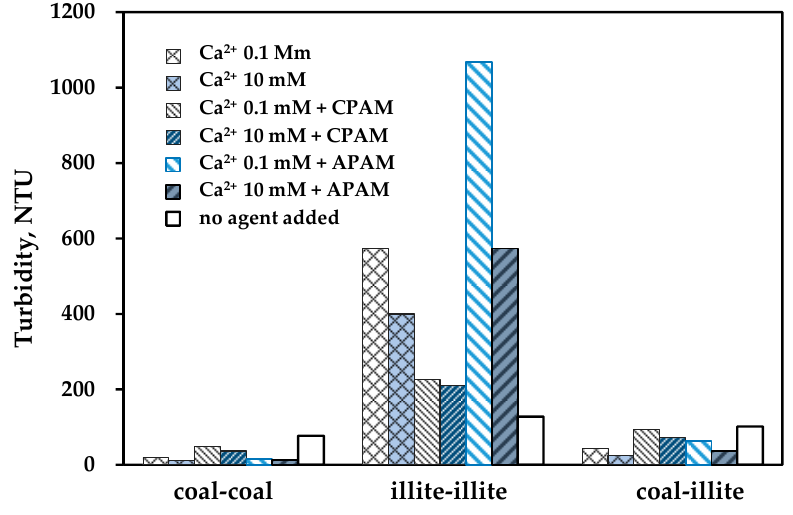
Figure 3. The supernatant turbidity of coal slime water after sedimentation using different agents; the dosage of PAM was 4.5 mg/L, if available.